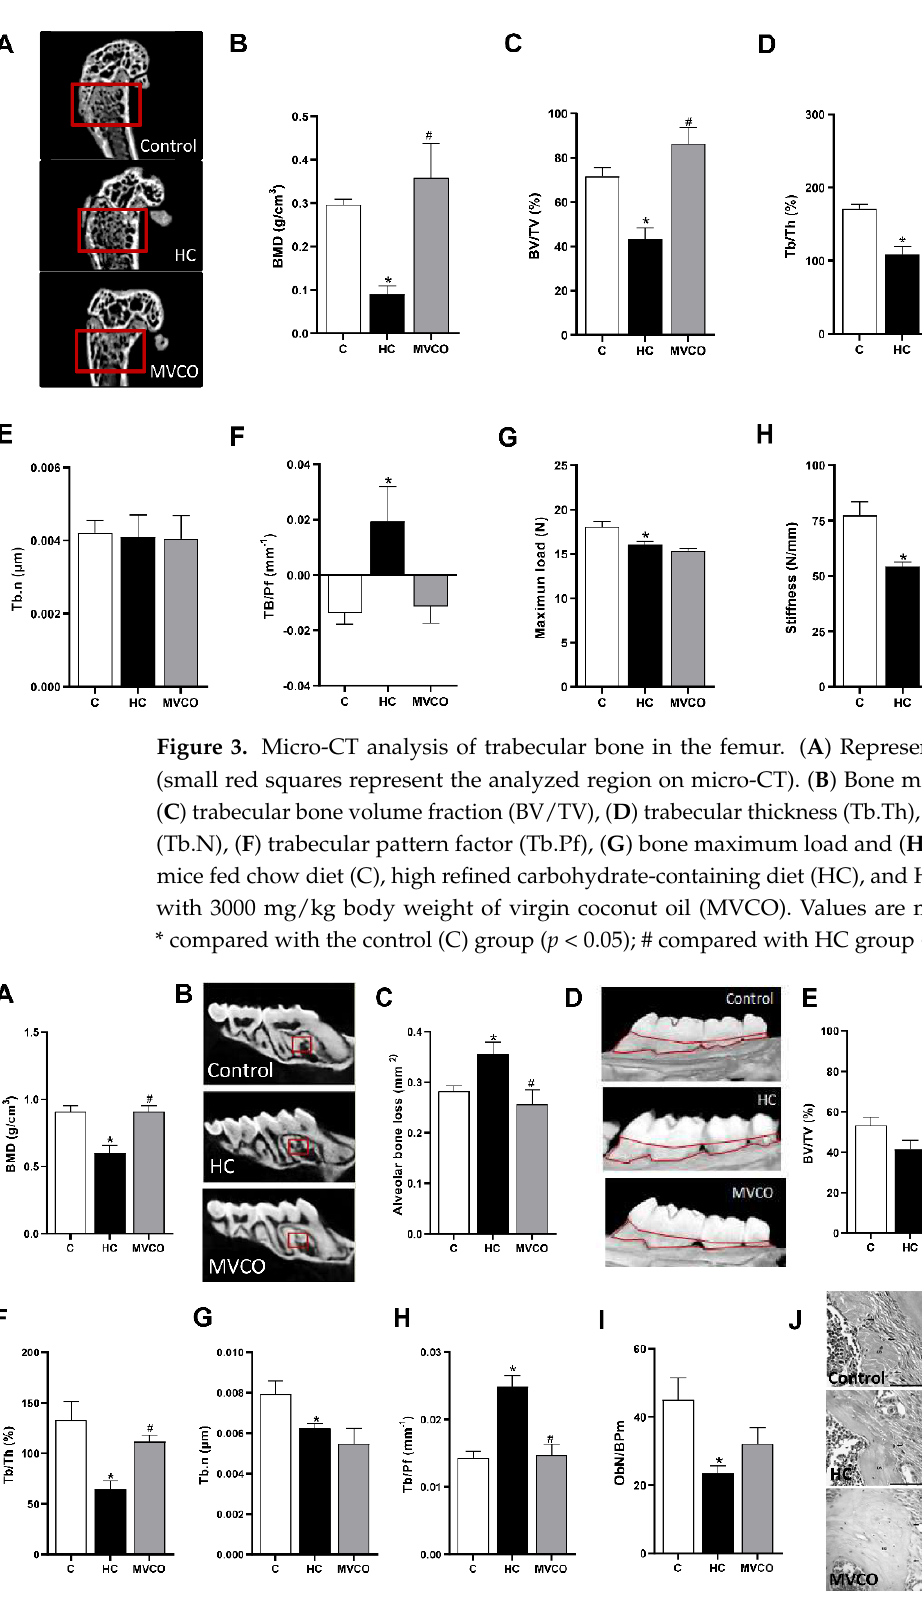
Figure 4. Micro-CT analysis of maxillary bone. ( A ) Bone mineral density (BMD), ( B ) representative images of maxillary (small red squares represent the analyzed region on micro-CT). ( C ) Alveolar